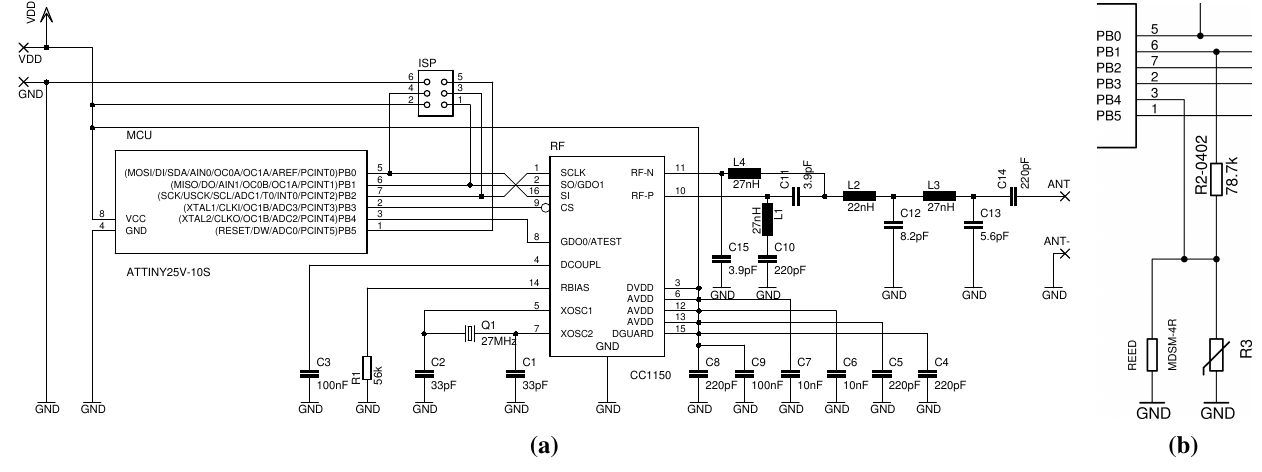
Figure 7. Schematic of the sensor node prototype for laboratory testing ( a ); issues fixed ( b ): (1) add a temperature transducer with an interface circuit and (2) add a means to switch the sensor to deployment